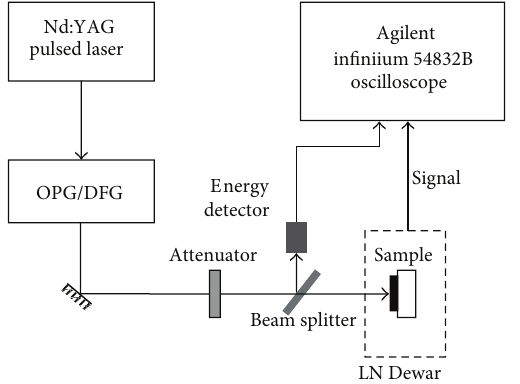
Figure 1: Schematic diagram of the transient photovoltage technol- ogy (not to the scale).